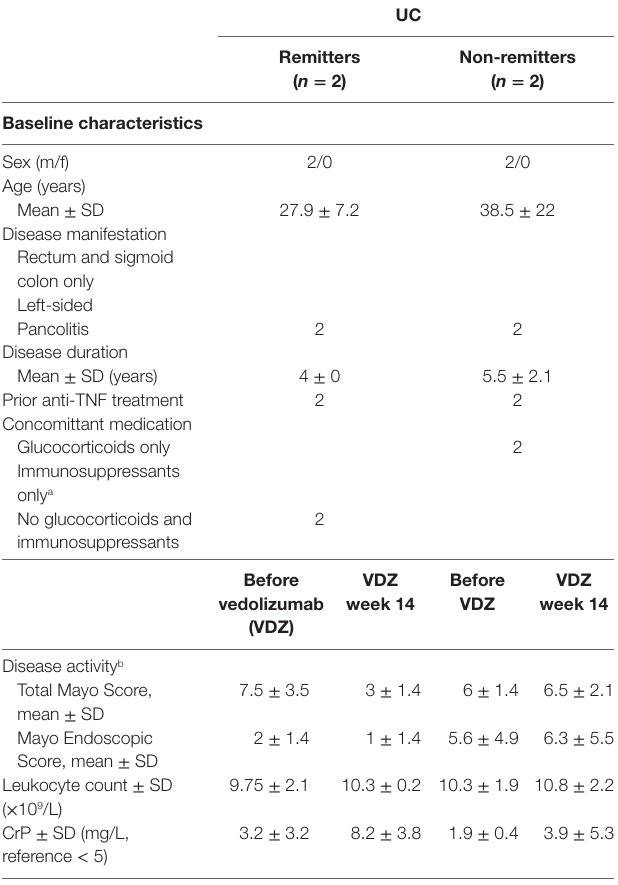
TaBle 2 | Clinical data of ulcerative colitis (UC) patients included for RNA sequencing.